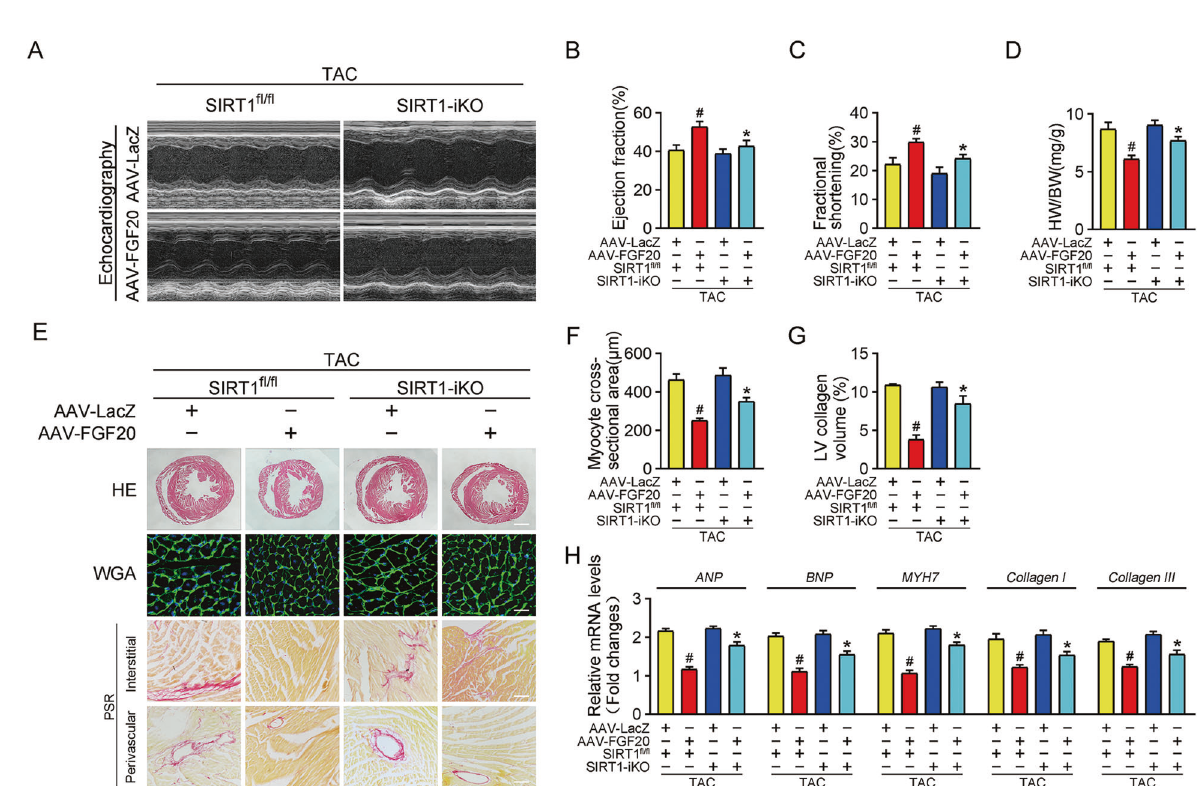
Fig. 7 Cardiac-speci fi c deletion of SIRT1 impairs the protective effect of FGF20 on cardiac dysfunction and hypertrophy in vivo. A Representative M-mode echocardiographic recording obtained from SIRT1 fl ox/ fl ox (SIRT1 fl / fl ) or SIRT1 inducible cardiac-speci fi c knockout (SIRT1-iKO) mice infected with AAV-LacZ or AAV-FGF20 followed TAC operation. B – D Quantitative analysis of LV ejection fraction (EF), fractional shortening (FS), and heart-to-body weight ratio (HW/BW), respectively. E HE staining (Scale bar = 0.8 mm) and WGA staining (Scale bar = 30 μ m) were performed to detect cardiac hypertrophy and PSR staining (Scale bar = 200 μ m) was were performed to detect cardiac fi brosis of SIRT1 fl / fl or SIRT1-iKO mice infected with AAV-LacZ or AAV-FGF20 followed TAC operation. F Quantitative analysis of cardiomyocyte cross-sectional areas (CSA) in E . G Quantitative analysis of LV collagen volume in E . H RT-qPCR analysis of the mRNA levels of hypertrophic marker genes ( ANP, BNP, and MYH7 ) and fi brosis marker genes ( Collagen I and Collagen III ) in the hearts of SIRT1 fl / fl or SIRT1-iKO mice infected with AAV-LacZ or AAV-FGF20 followed TAC operation. n = 5 per group, # P < 0.05 versus TAC + AAV-LacZ + SIRT1 fl / fl group, * P < 0.05 versus TAC + AAV-FGF20 + SIRT1 fl / fl group Data represent means ± SEM, Two-tailed Student ’ s t